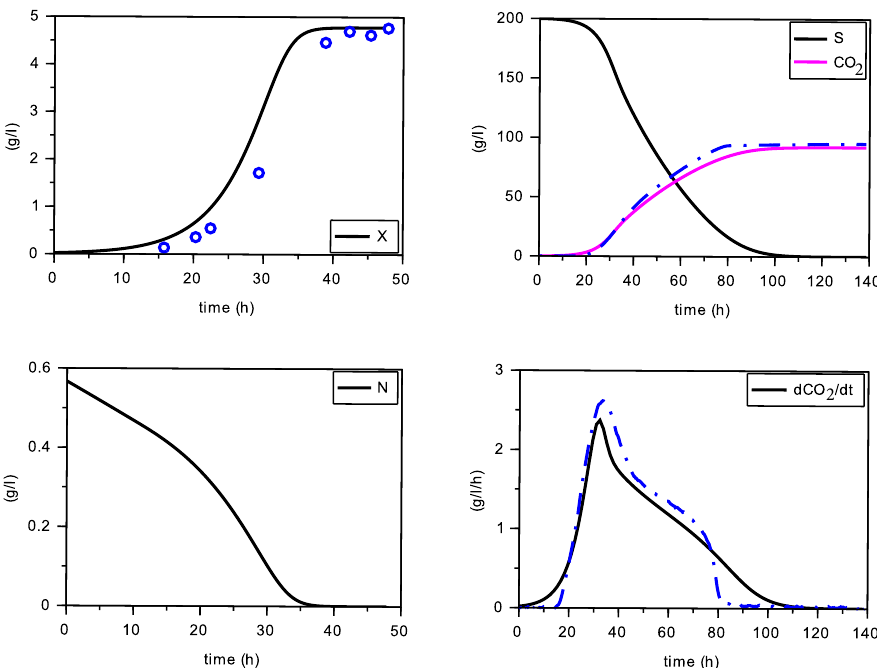
Figure 16. Simulation for N ( 0 ) = 0.567 g · L − 1 (experimental data in blue).